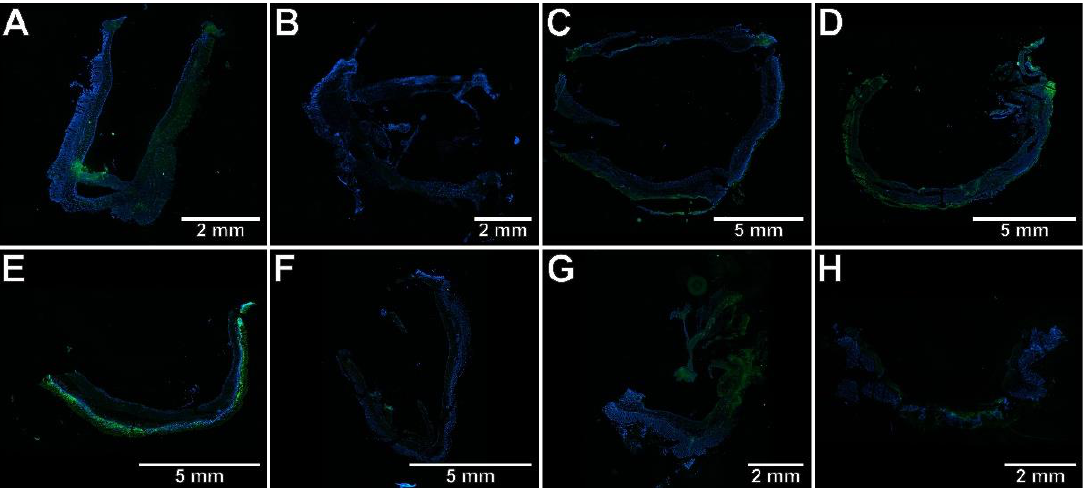
Figure 4. The photomicrographs of cryosections of the whole colon tissue samples after immunostaining with antibodies specific to ROR γ t fluorescently detected demonstrated that only compound 7b counteracted TNBS-induced increase in ROR γ t expression. Control group ( A ); group receiving only TNBS ( E ); group receiving 10 mg/kg compound 7b and TNBS ( B ); group receiving 20 mg/kg compound 7b and TNBS ( F ); group receiving 10 mg/kg compound 10b and TNBS ( C ); group receiving 20 mg/kg compound 10b and TNBS ( G ); group receiving 10 mg/kg compound 13b and TNBS ( D ); group receiving 20 mg/kg compound 13b and TNBS ( H ); magnification 4 × .